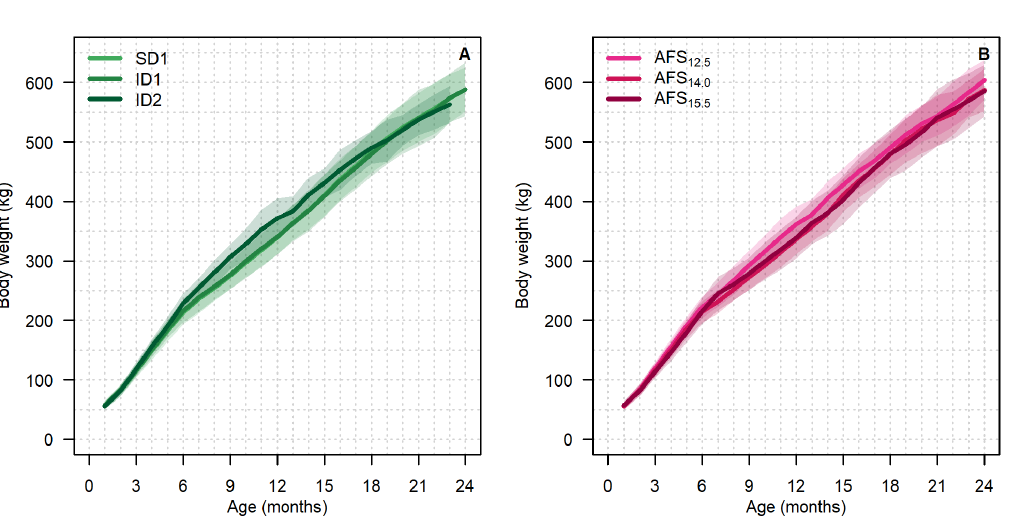
Figure 1. Mean body weight of heifers during the rearing period by (A) feeding treatment (SD, ID1, ID2: animals fed a standard (SD) or increased-plane (ID1 & ID2) feeding treatment) and (B) class of age at first service (AFS). Shaded areas are the dispersions of the data around the means (± one standard